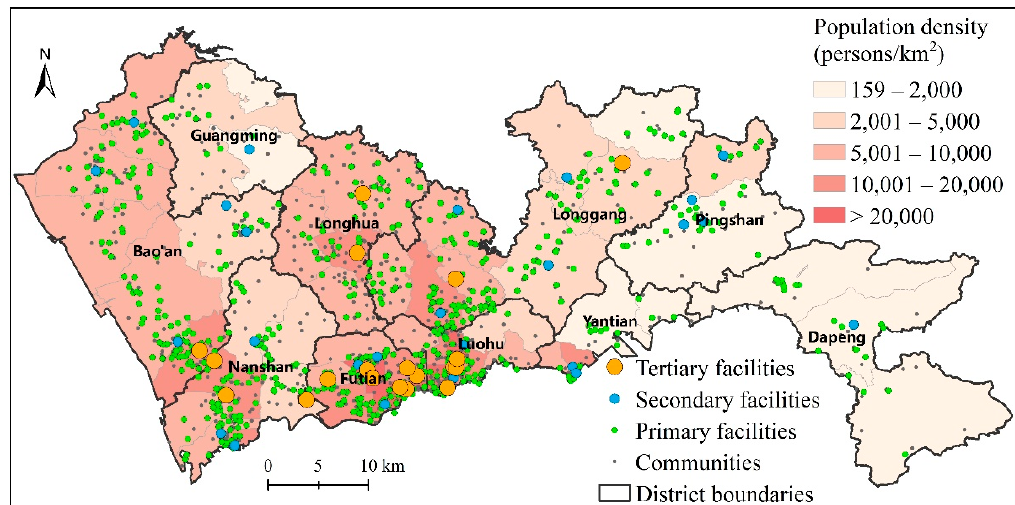
Figure 1. Location and distribution of population and healthcare facilities in Shenzhen.